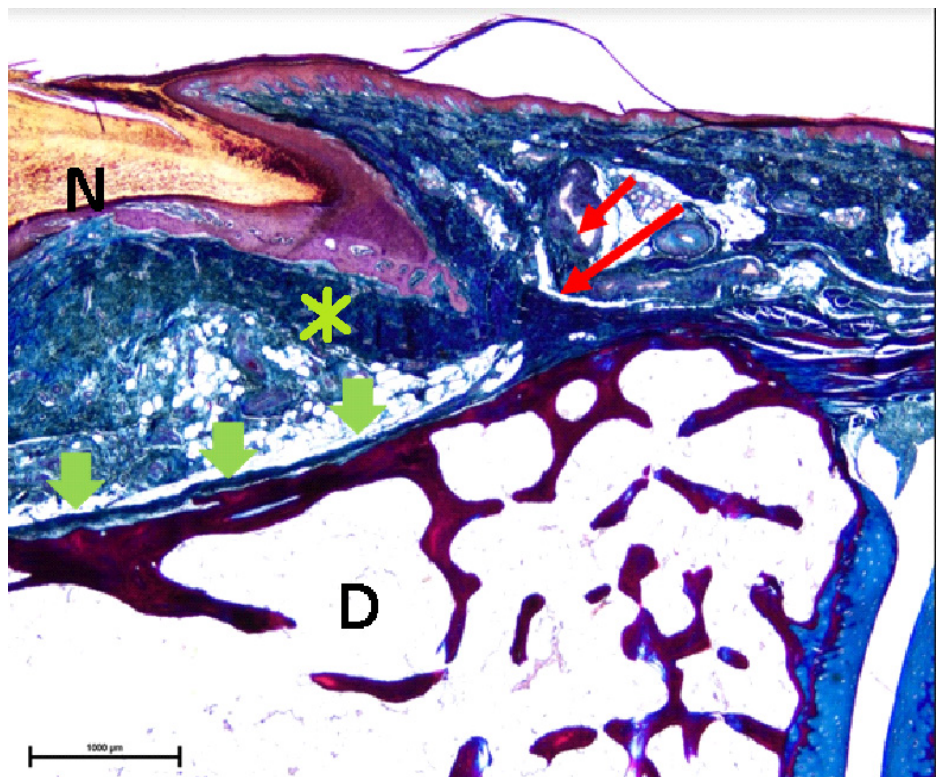
Figure 3. High-power magnification detail of the superficial fibers of the Extensor Digitorum Longus (EDL) bundles (red arrows) attached at the base of ventral matrix (asterisk) to the underlying distal phalanx (D) bone, crossing the deep fibers of the EDL tendon bundles (green arrowheads). Superficial fibers of the EDL tendon expansion to the eponychium (red arrow), which run distally along the complete dorsal aspect of the distal phalanx until its end (20× magnification). Tetrachrome VOF-III GS stain (light green SF/or fast green FCF, methyl blue, Orange G, and acid). N—nail plate; D—distal phalanx. Scale bar = 20× magnification